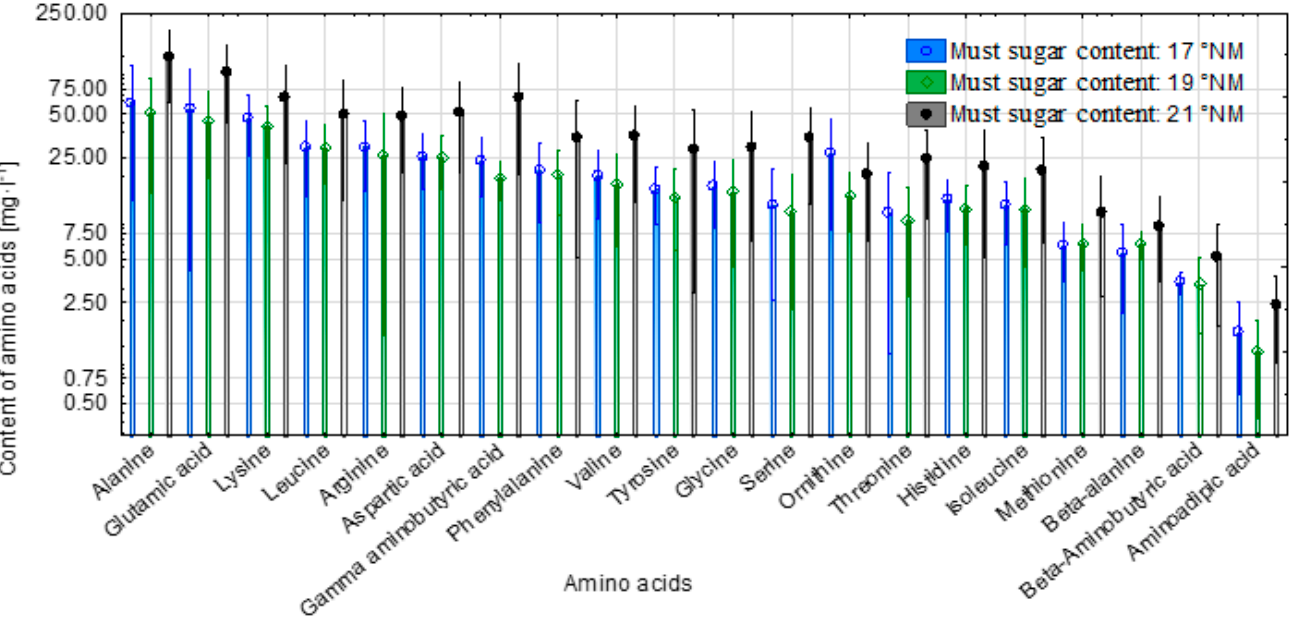
Figure 3. Comparison of the average amino-acid content of the basic wine, wine fermented with immobilized yeast, and wine fermented with classical yeasts.